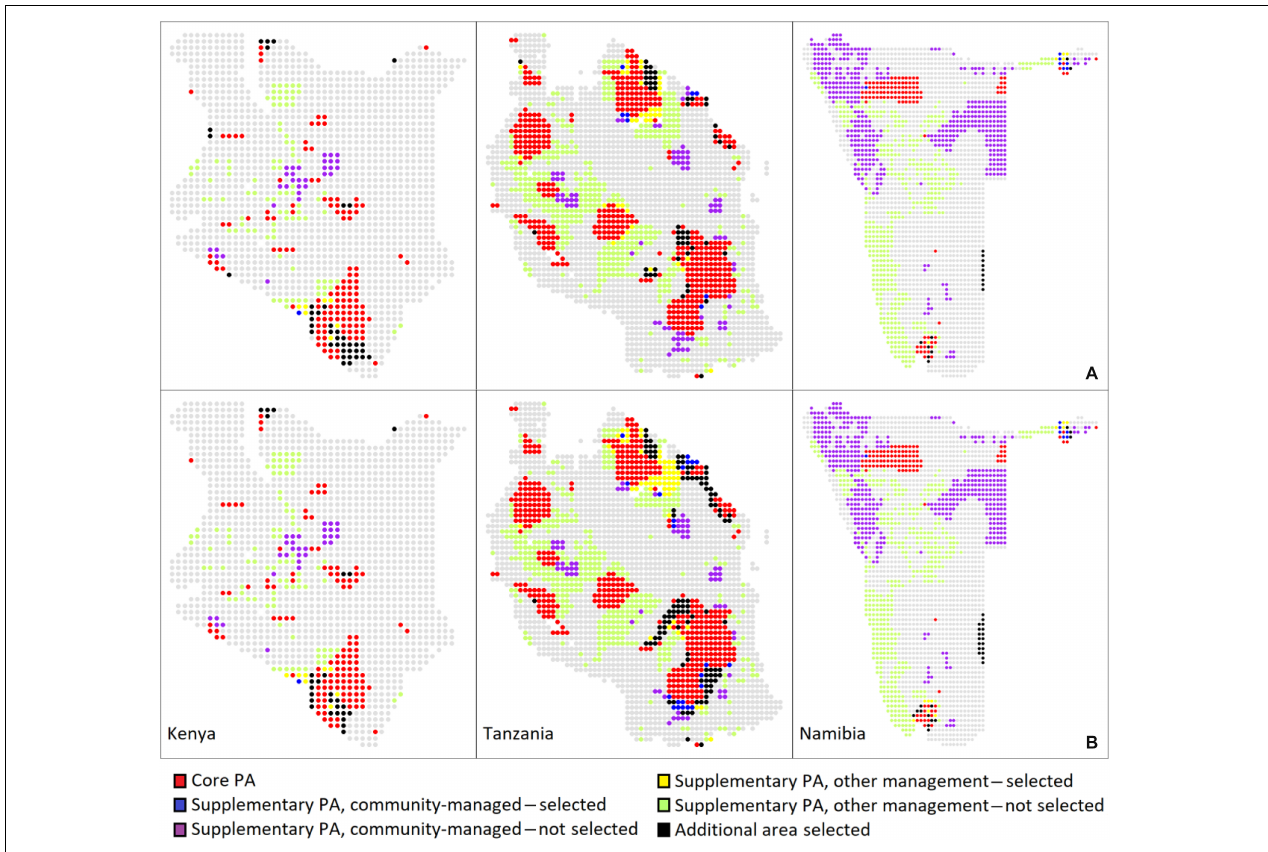
FIGURE 3 | PA networks and priority areas in three sub-Saharan countries. Areas selected for protection to complement the core PA network in a continent-wide gap analysis are shown in relation to the current PA network from WDPA. (A) Solutions under the bioclimatic envelope approach. (B) Solutions under the conservative approach where species are unable to